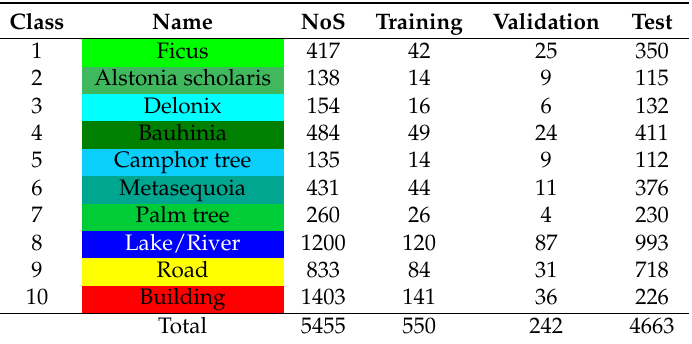
Table 3. Number of Samples (NoS) and training samples used in the